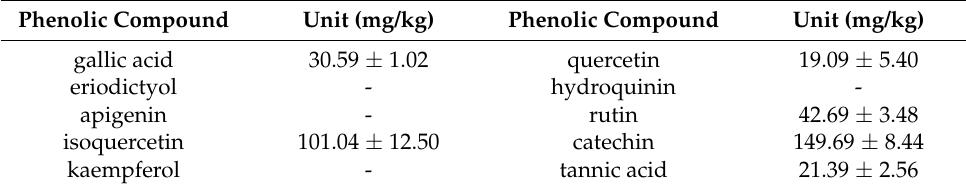
Table 2. The phenolic compounds of the dried banana inflorescence.